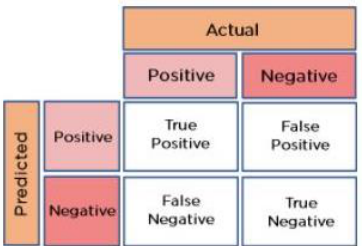
Figure 5. Confusion Matrix